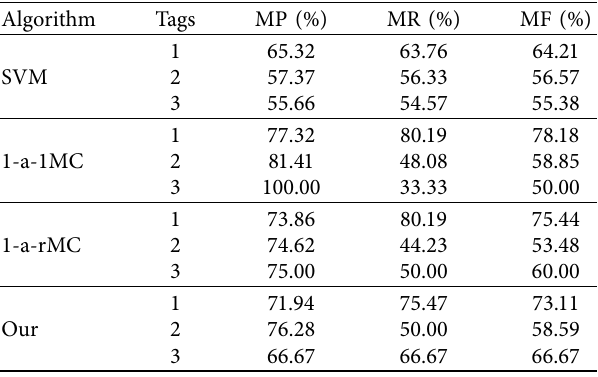
Table 4: Comparison of different